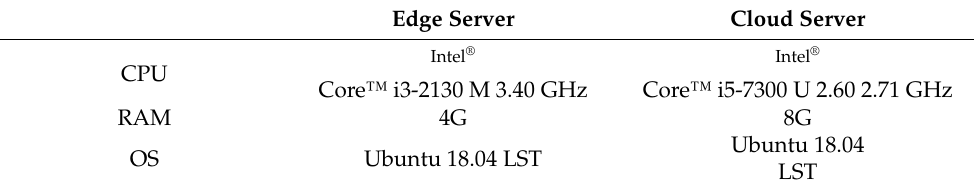
Table 2. Configuration of system